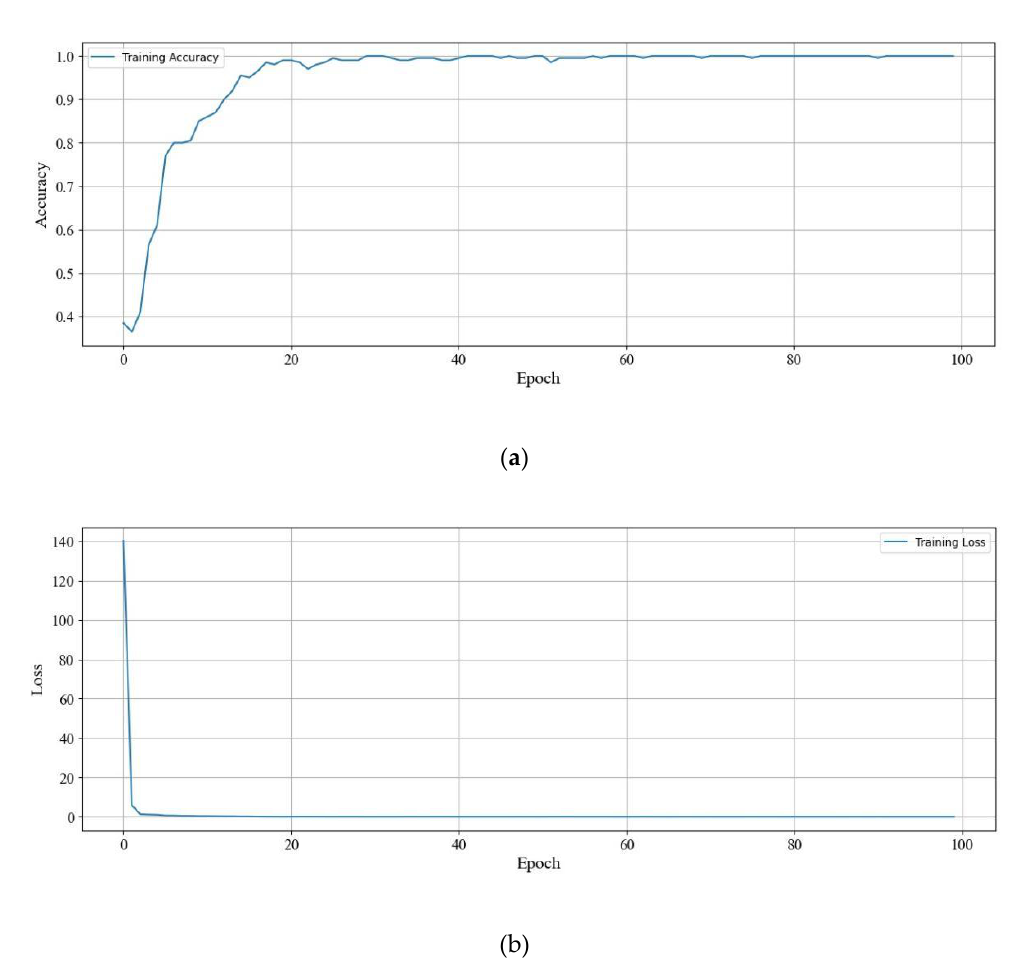
Figure 8. Accuracy and loss of the CNN model after 100 epochs of training: ( a ) the accuracy of the CNN model after 100 epochs of training; ( b ) the loss of the CNN model after 100 epochs of training.